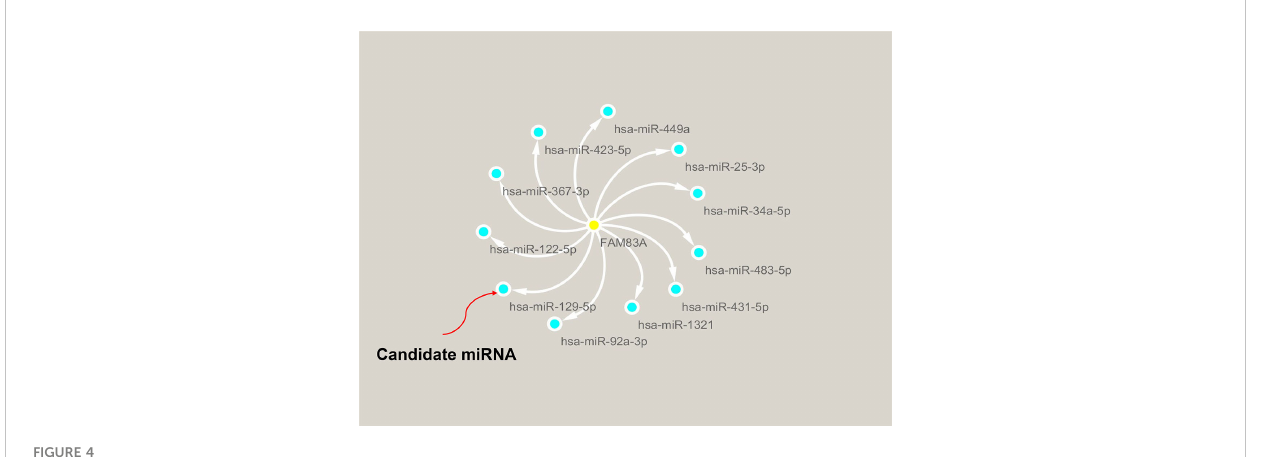
signi fi cantly highly expressed in tumorous PC tissues obtained from patients compared with that in normal controls (Figure S3), which shows the ncRNAs ( hsa-miR-129-5p and AL049555.1 ) play the pivotal roles in tumorigenesis and progression of PC, and may be considered to have abilities to regulate the expression of FAM83A . memory B cells and M0 macrophage in fi ltration in PC, with signi fi cant changes in B cells, CD4+ T cells, and CD8+ T cell